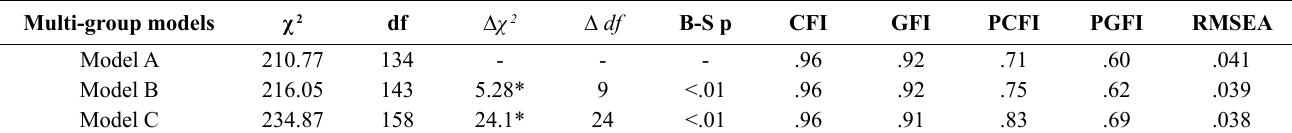
Table 2. Results of the Multi-Group Analysis across the Unconstrained Model and the Constrained Models of the PFAI (Testing Sample: n = 350; Validation Sample: n = 206) Multi-group models